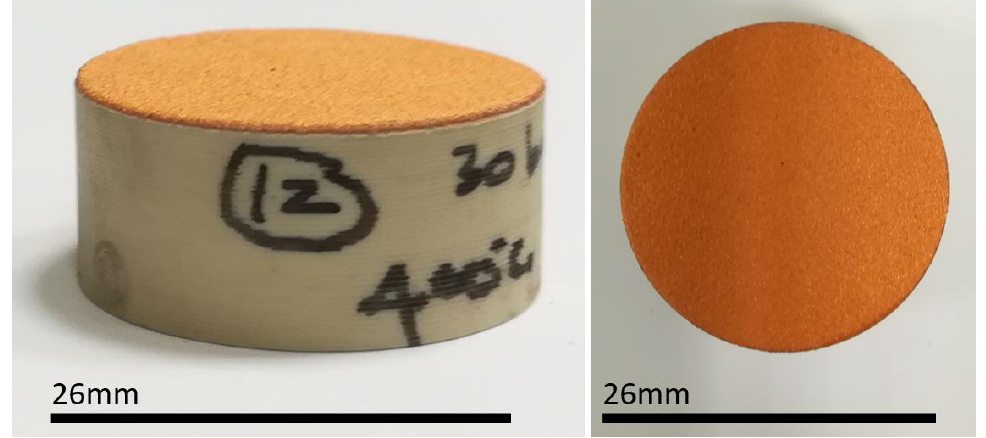
Figure 7. Typical continuous Cu coating onto a cylindrical PEEK substrate (diameter of 26 mm and thickness of 10 mm), obtained with a 5 passes deposition with (30 bar, 400 °C, 135 mm, 200 mm/s).